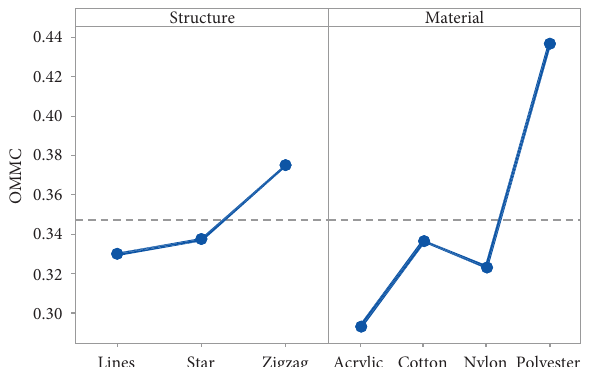
Figure 25: Main efect plot of